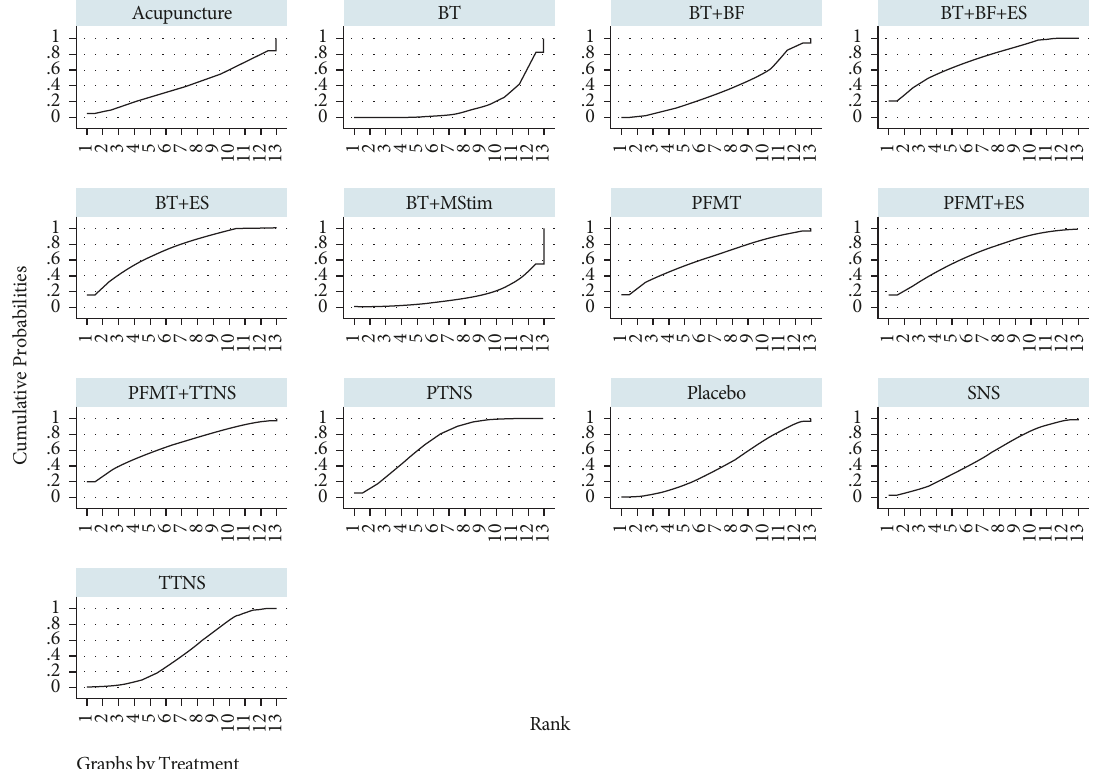
Figure 7: Cumulative ranking curves for the daytime micturition frequency.